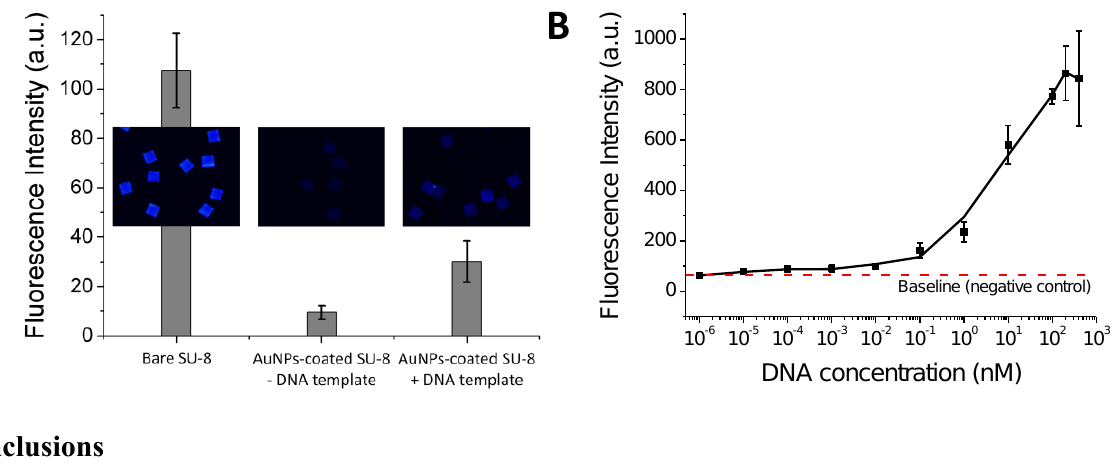
Figure 3. SP-PCR is performed with 2 ng/µL genomic DNA purified from C. jejuni ( A ), and different molar concentrations of a pre-amplified 302-bp DNA fragment of the 16S Ribosomal gene ( B ). NC: negative